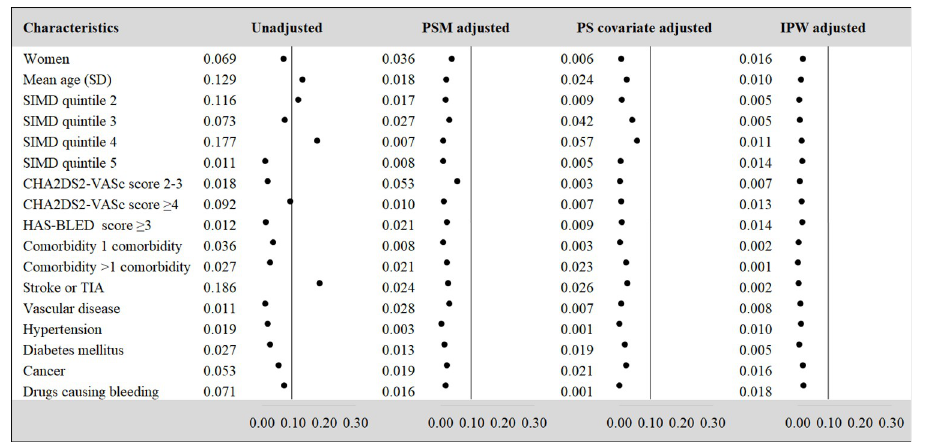
Fig 3. Covariate imbalance assessment for dabigatran vs. warfarin. Note: PS = Propensity Score, PSM = Propensity Score Matching, IPW = Inverse Probability Weighting, SIMD = Scottish Index of Multiple Deprivation, TIA = Transient Ischaemic Attack.